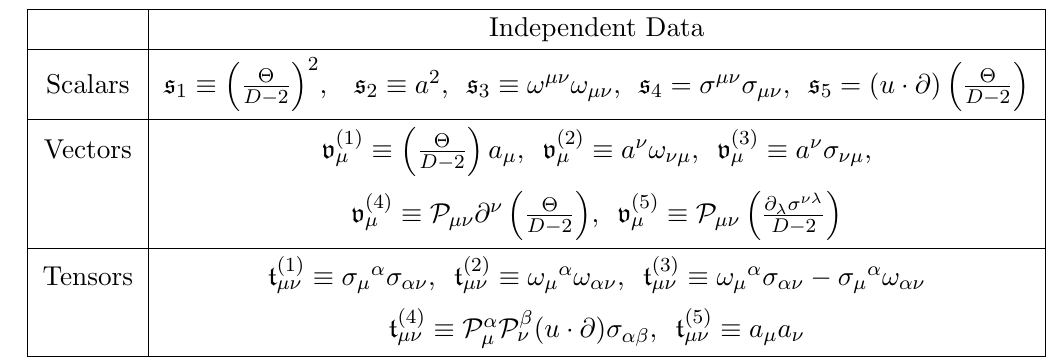
Table 1 . Data at 1st order in derivative.